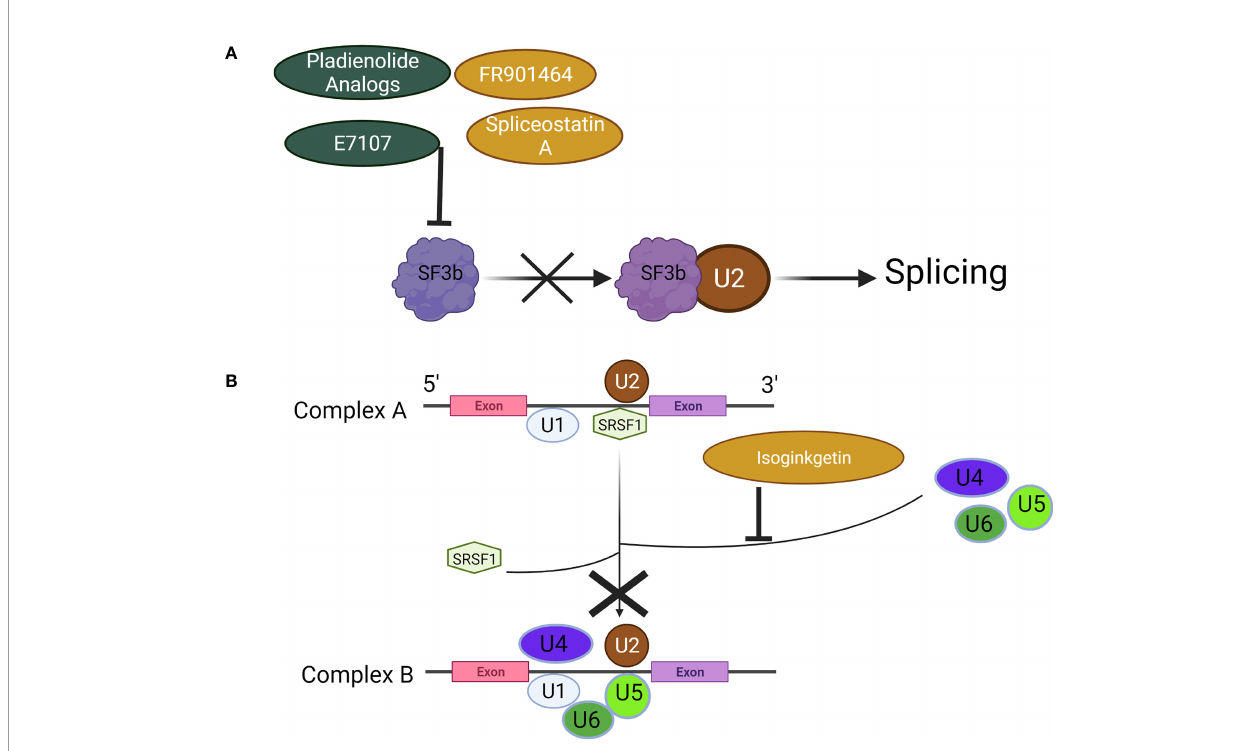
FIGURE 4 | Mechanisms of Spliceosome Inhibitors. (A) Pladienolides, FR901464, and their analogs suppress the spliceosome by binding to SF3b to prevent its association with U2, (B) Isoginkgetin prevents the recruitment of the U4/U5/U6 tri-snRNP, halting the spliceosome at Complex A. Created with